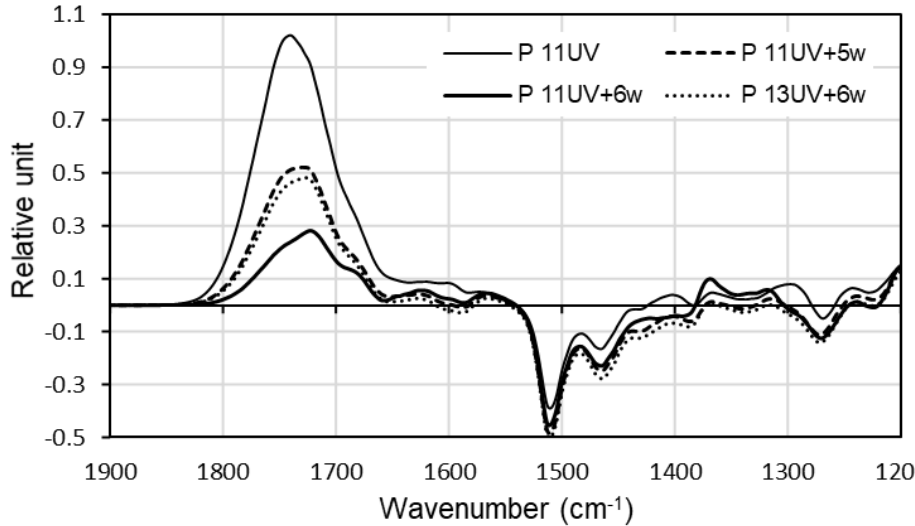
Figure 5. Difference FTIR spectra of Scots pine ( p ). 11 UV = eleven-day UV irradiation; xUV + yw is an abbreviation where x is the extent of UV irradiation, and y is the extent of water leaching in days.